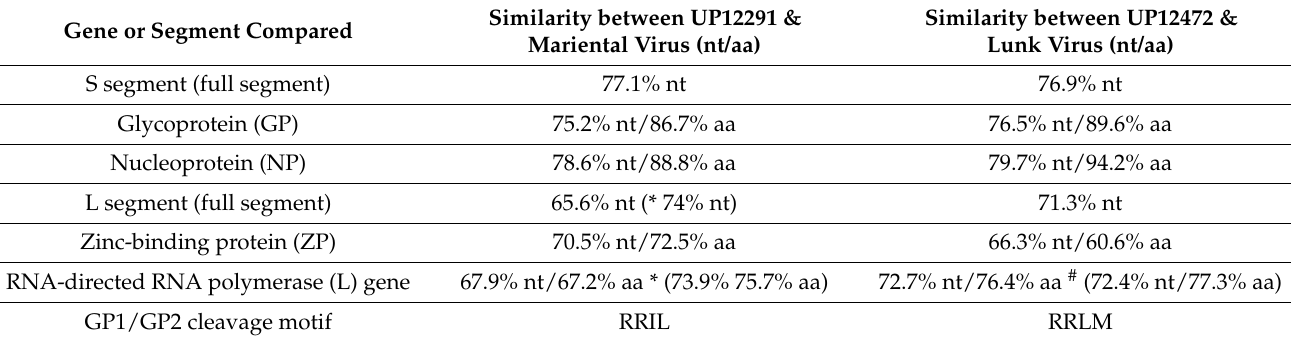
Table 2. Similarities between reference species and genomes identified in this study.